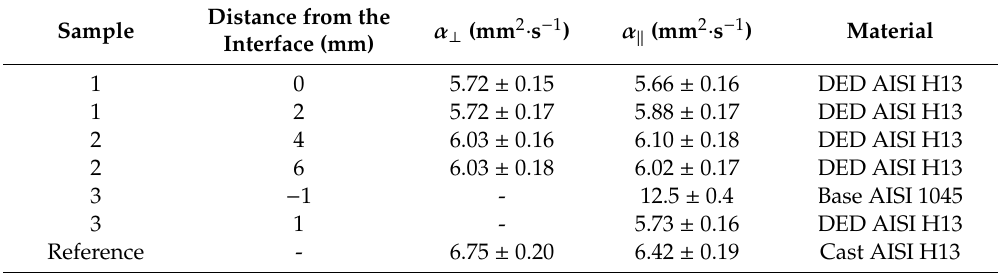
Table 5. Thermal di ff usivity Table 5. Thermal diffusivity results.